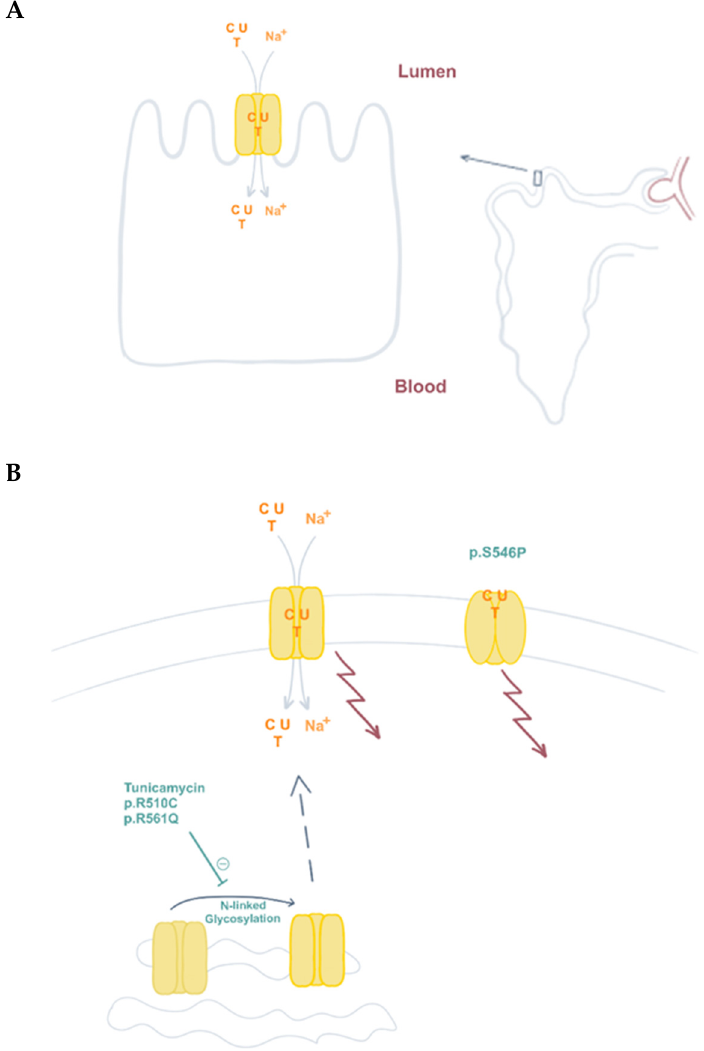
Figure 5. CNT1 function and presence at the plasma membrane contribute to pyrimidine reab- sorption in the kidney. ( A ) CNT1 is expressed at the apical plasma membrane of kidney proximal tubule epithelial cells, where it is responsible for pyrimidine reabsorption (C, cytidine; U, uridine; T; thymidine). ( B ) N-linked glycosylation contributes to CNT1 plasma membrane localization. This post-translational modification of the protein is partially impaired in variants p.R510C and p.R561Q, causative of URCTU. CNT1 also functions as a transceptor. Besides pyrimidine translocation, it can also induce changes in signaling pathways (arrows, see text), regardless of its transporter function. Variant p.S546P lacks this translocation ability, but is properly located at the plasma membrane and retains some wild type transceptor